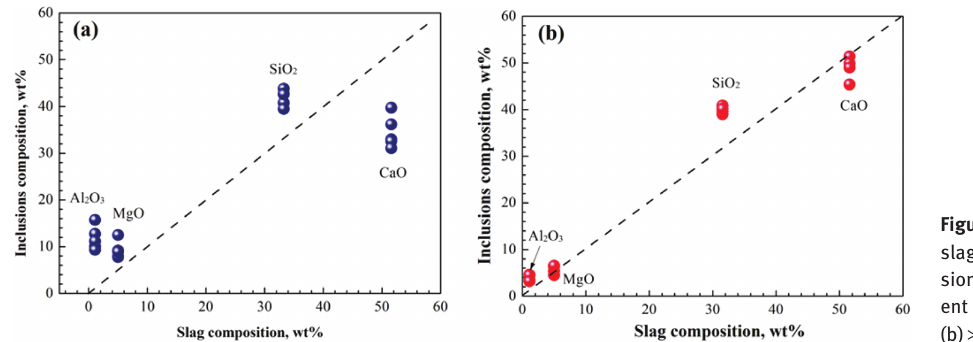
Figure 7: Comparison between slag composition and inclu- sions composition with differ- ent sizes. (a) 5 ～ 10 μ m, (b) > 10 μ m.